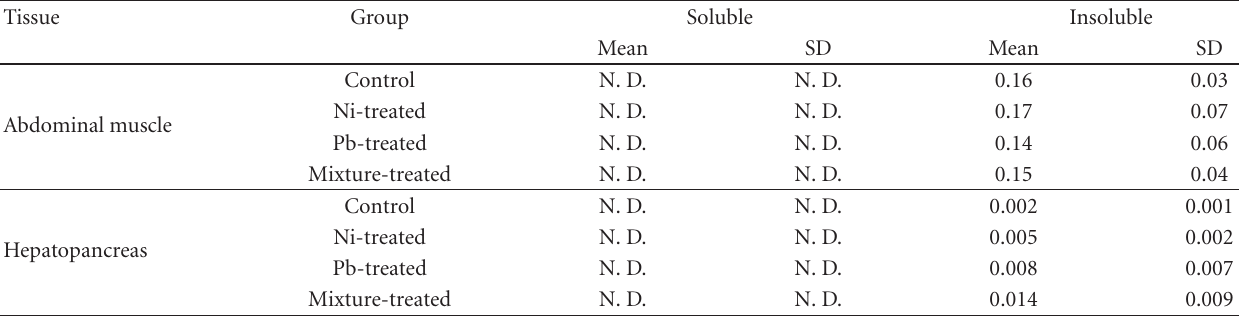
Table 3: Lead concentration (mgKg − 1 ) in abdominal muscle and hepatopancreas from P. vannamei, according to the soluble and insoluble